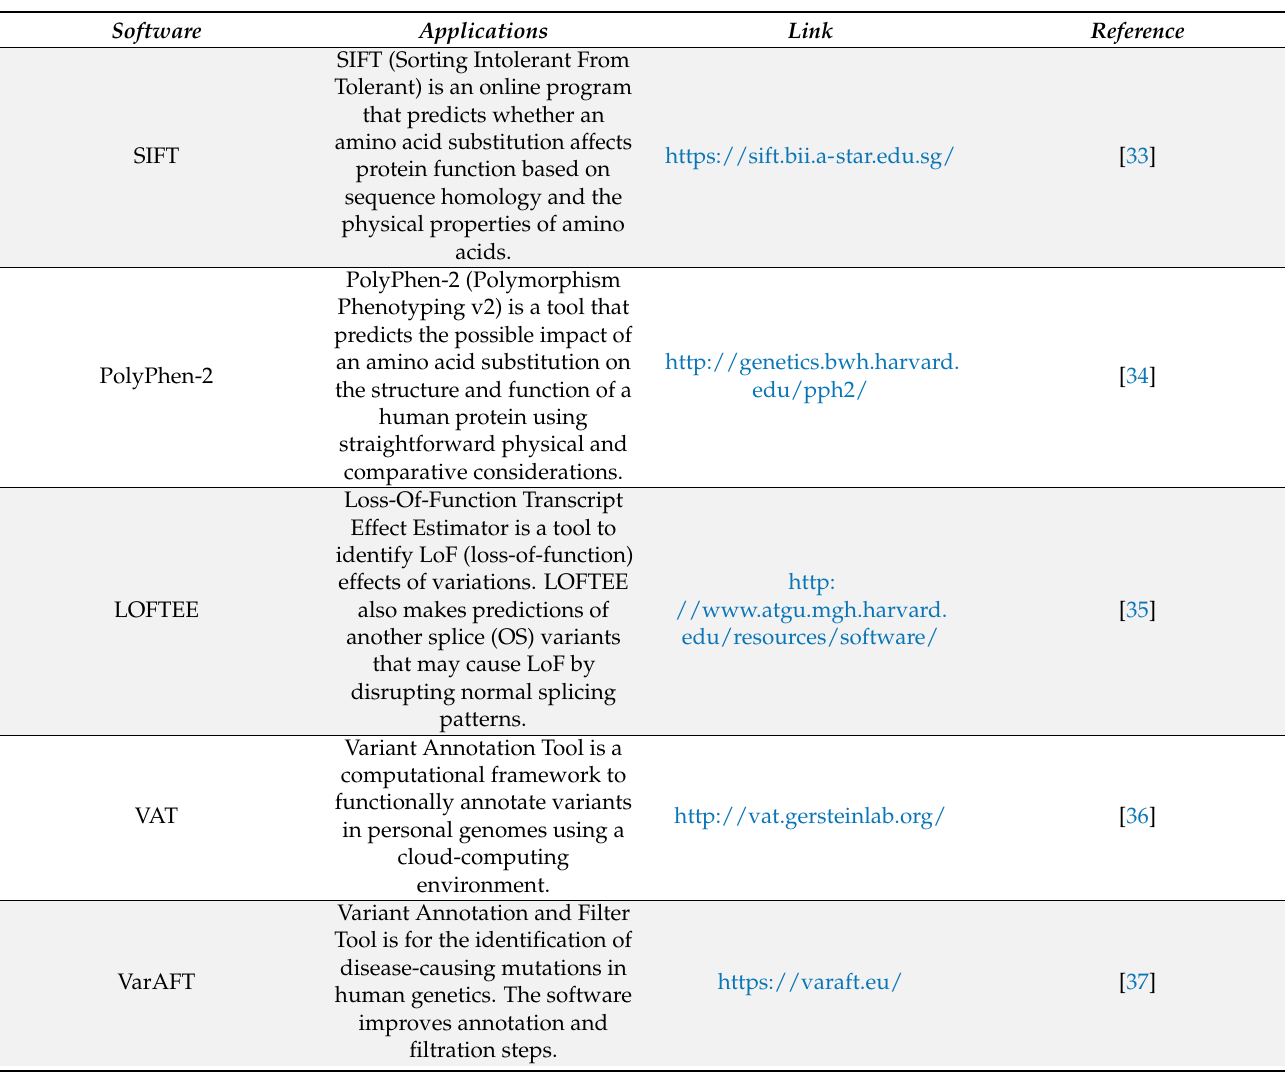
Table 3. Special data mining and visualization tools and algorithms, used in PGx data analyzing and phenotype prediction.